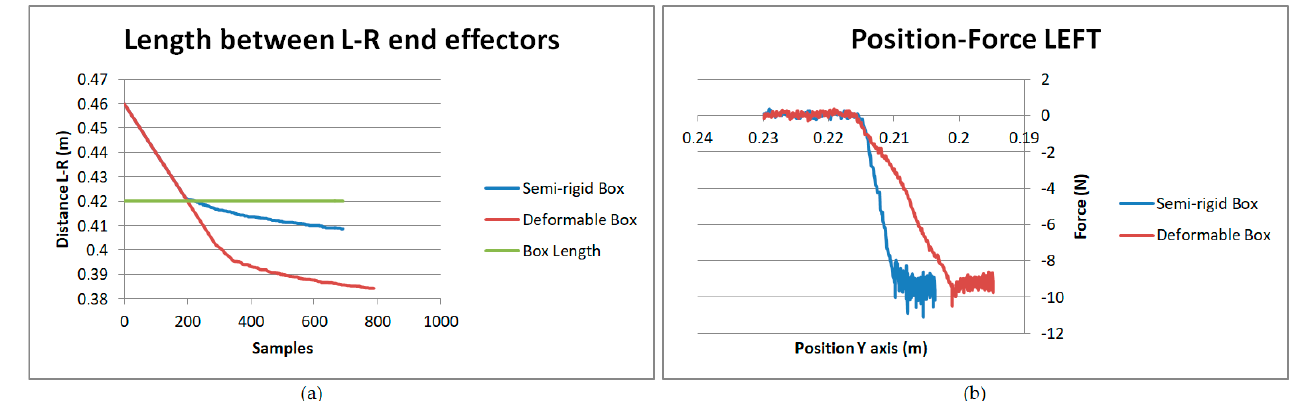
Figure 14. ( a ) Distance between both arms and the box deformation. ( b ) Relation between the position of the end effector and the force applied to the box to lift it.